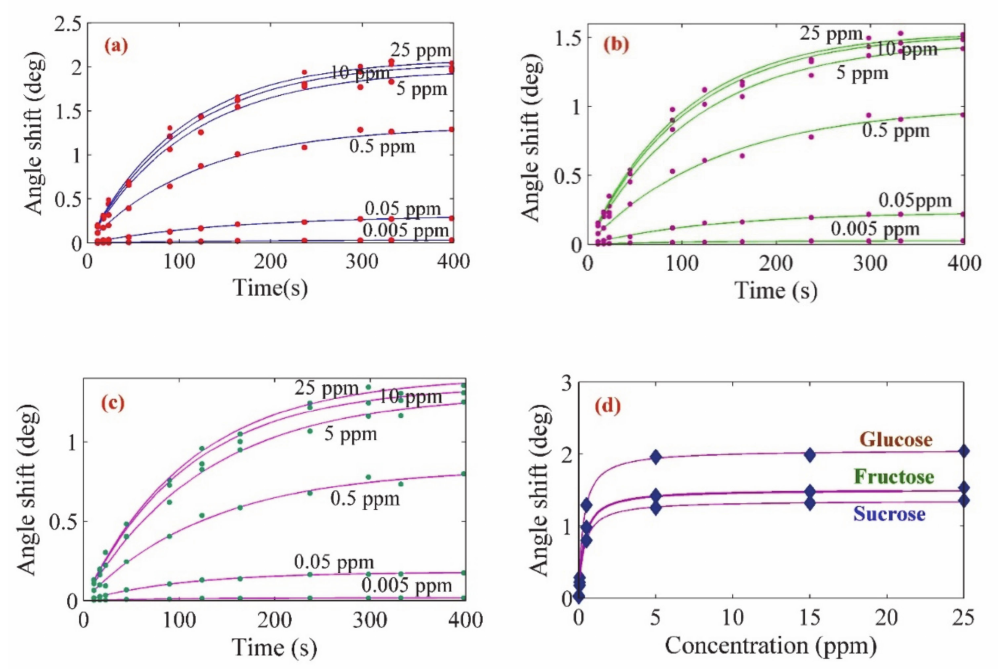
Figure 5. The variation of the resonance angle shift with time-related to ( a ) glucose, ( b ) fructose, and ( c ) sucrose. ( d ) Variation of the resonance angle shift with the concentration of the